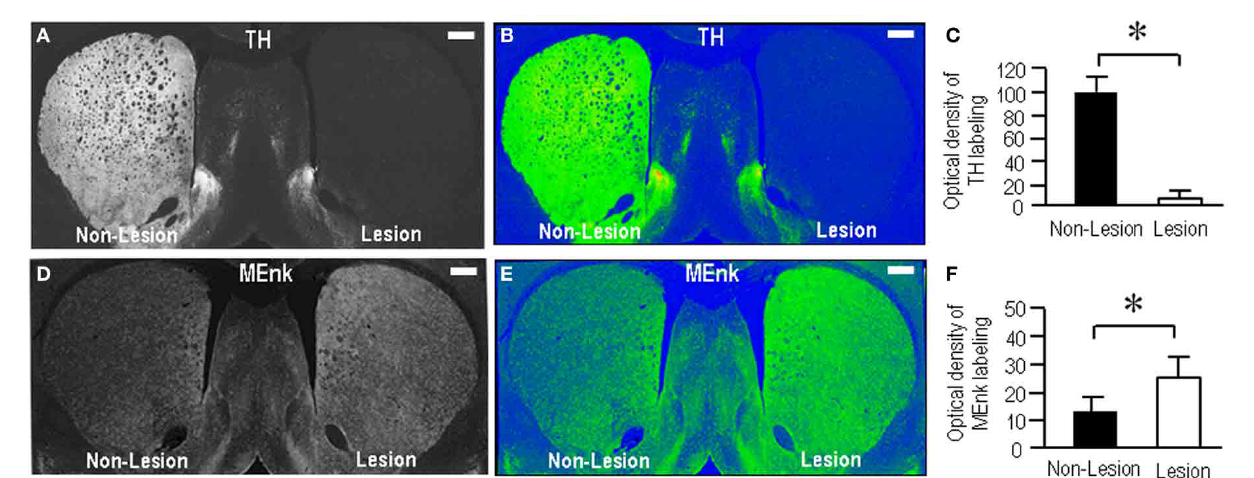
means ± S.E.M. ∗ P < 0 . 001 (Mann–Whitney U -test), Non-Lesion vs. Lesion. (D,E) A representative image of the forebrain sections stained for Met-enkephalin (MEnk).Anincrease instriatal Met-enkephalin labeling isfound on the lesioned side (Lesion) compared to the non-lesioned side (Non-Lesion). Its color-converted image is shown in (E) . The intensity of the labeling is shown in a standard pseudocolor scale. (F) Optical density measurements of striatal Met-enkephalin labeling in the lesioned striatum (Lesion) ( n = 25) compared to the non-lesioned striatum (Non-Lesion) ( n = 25). Values are means ± S.E.M. ∗ P < 0 . 01 (Mann–Whitney U -test), Non-Lesion vs.